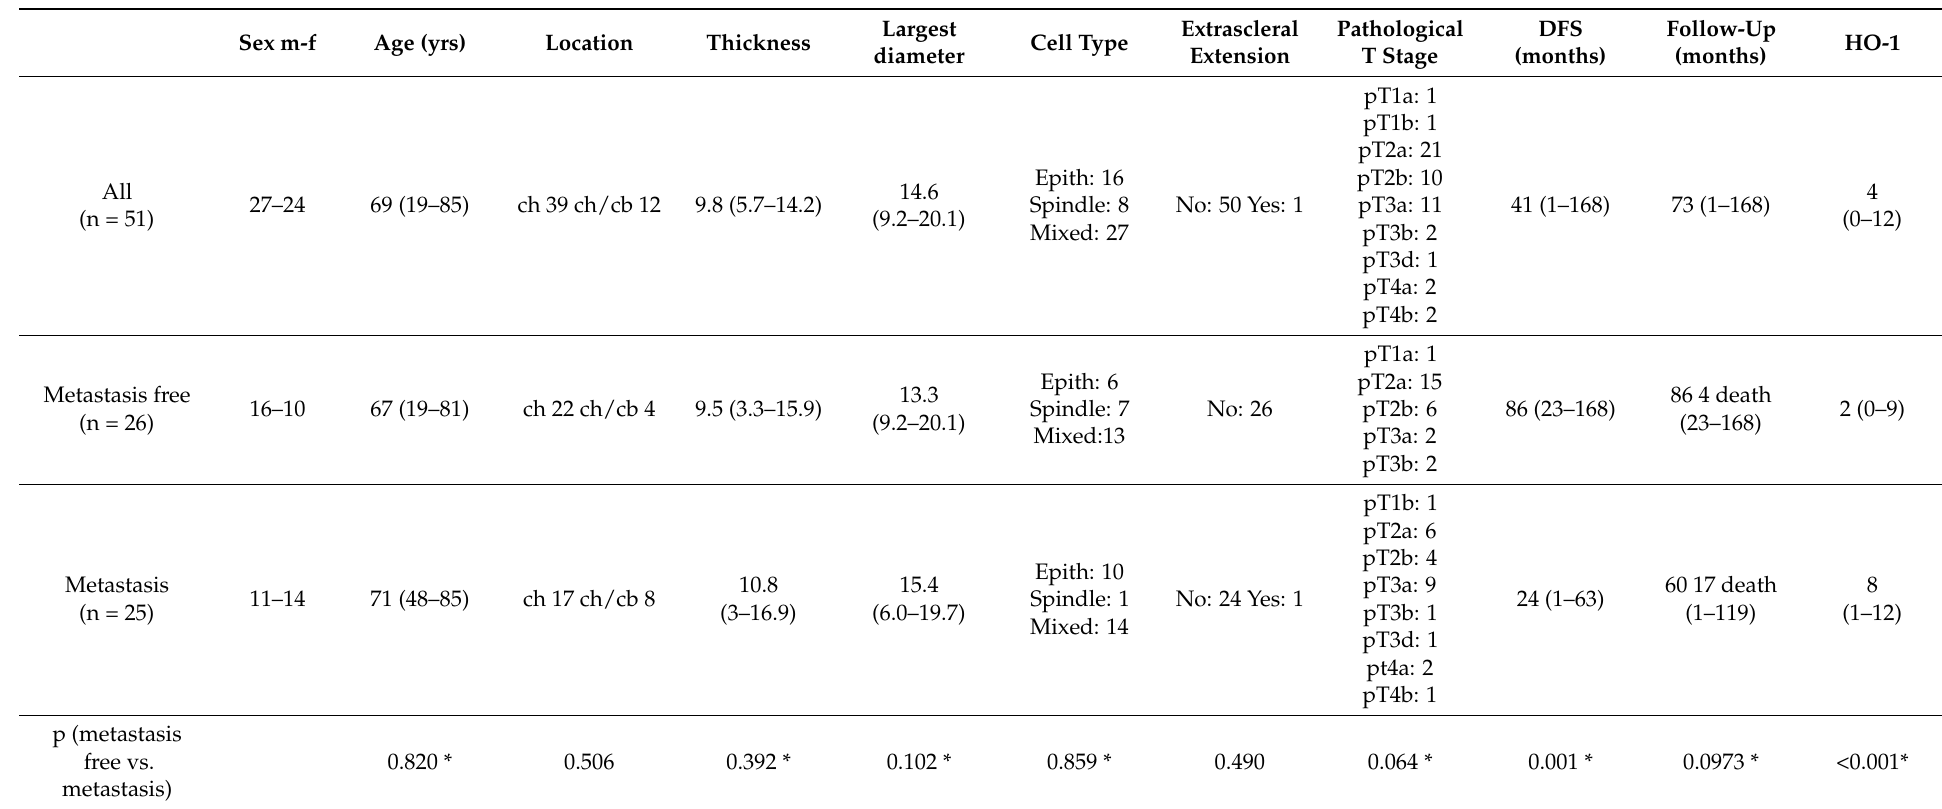
Table 4. Median (range) of demographics, tumor parameters, disease-free time, follow-up, and HO-1 expression in primary uveal melanoma with and without systemic